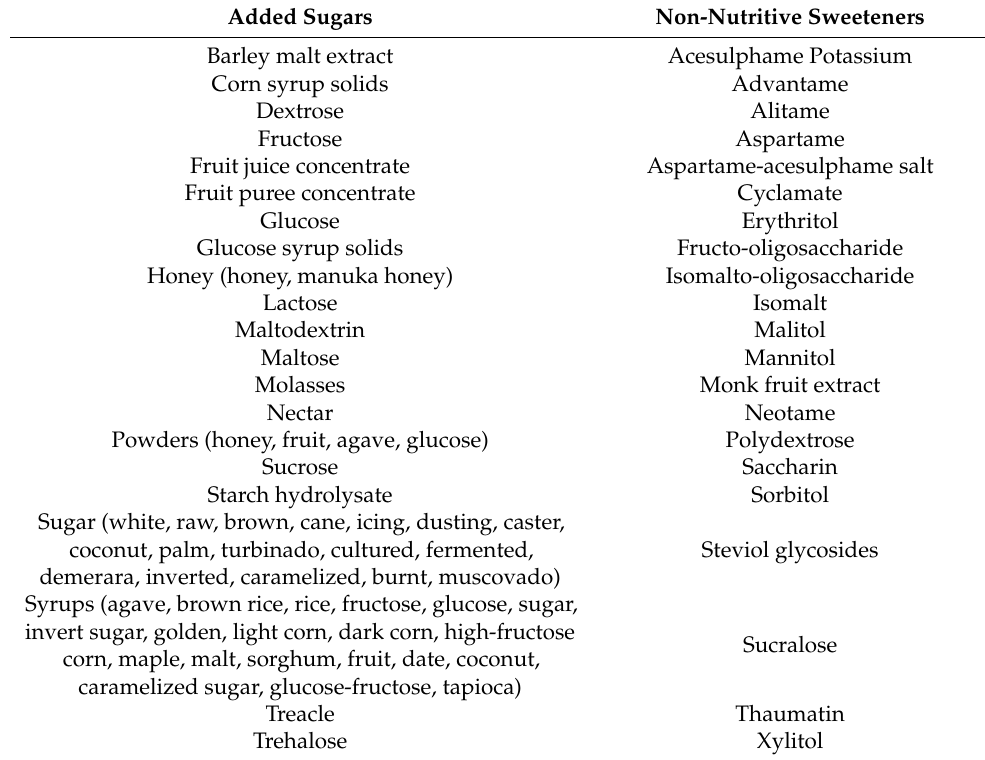
Table 1. Add sugars and non-nutritive sweeteners included in the